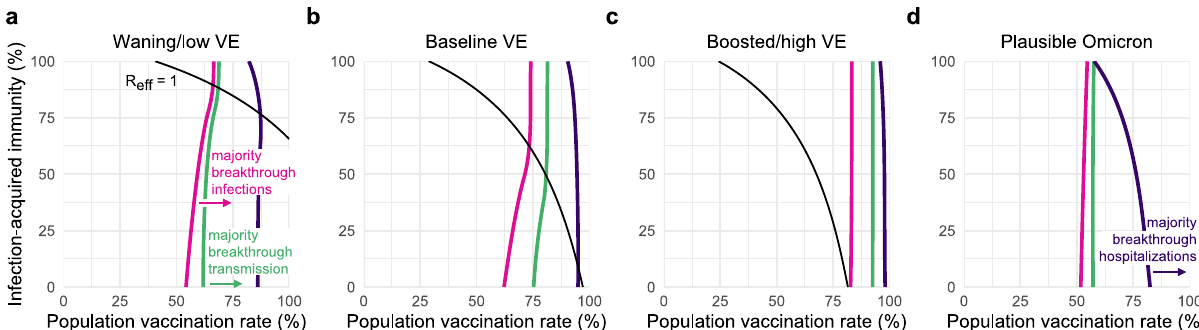
Fig. 3 Transition points for breakthrough infections, hospitalizations, and transmission. All panels show curves representing the vaccination and prior infection rates infections (pink), transmission (green), and hospitalizations (purple) are composed of equal numbers of vaccinated an unvaccinated individuals, with majority-breakthrough regions to the right of each line as indicated, for a waning/low, b baseline, and c boosted/high VE vs. the delta variant, and d plausible VE vs. the omicron variant. Black lines indicate R eff = 1 isoclines, which do not appear in d due to R eff > 1. See Supplementary Table 2 for immunity parameter values. R NPI ¼ 4 in 0 majority-unvaccinated vs. majority-breakthrough hospitalizations (Fig. 3, purple lines), and between majority-unvaccinated vs.